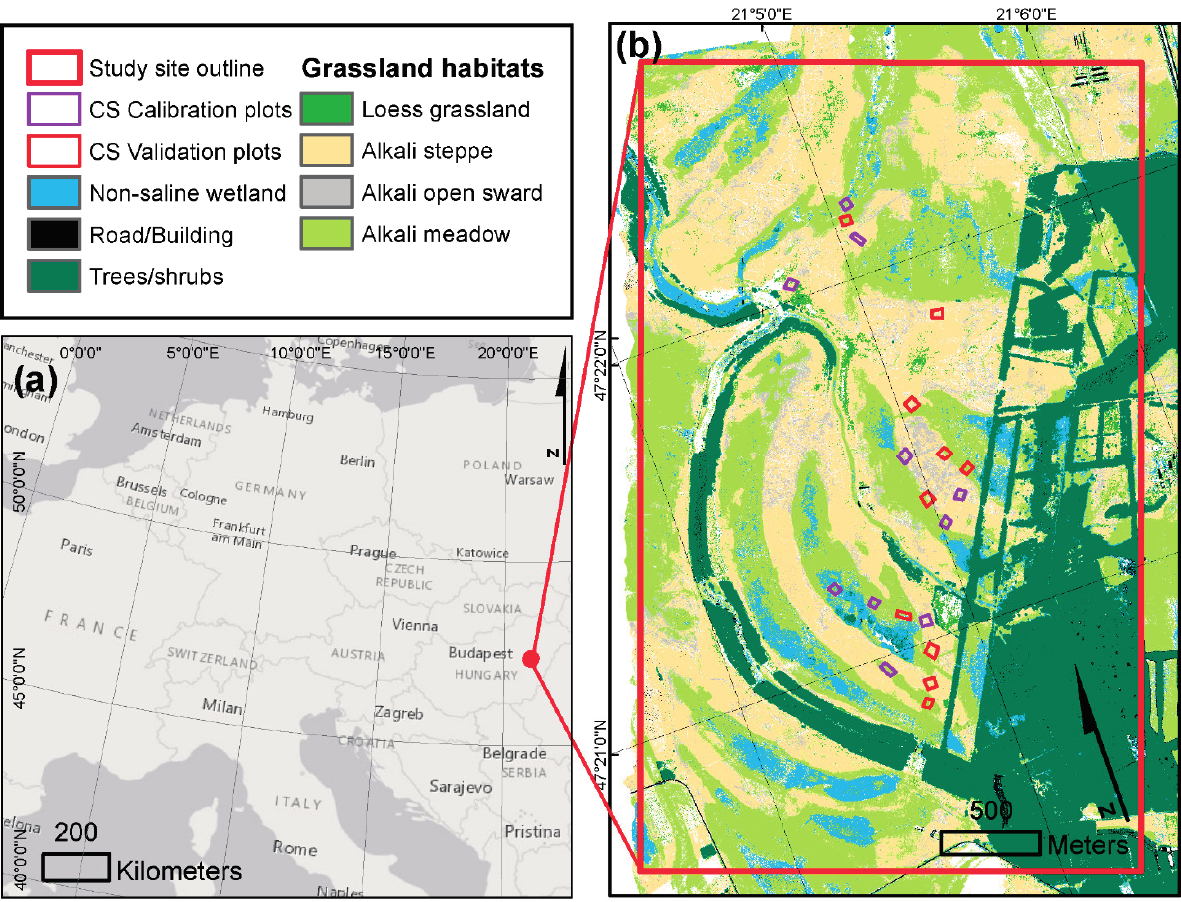
Figure 1. ( a ) Location of the study site in Central Europe; ( b ) overview of the study site including land cover, main alkali vegetation classes and CS reference